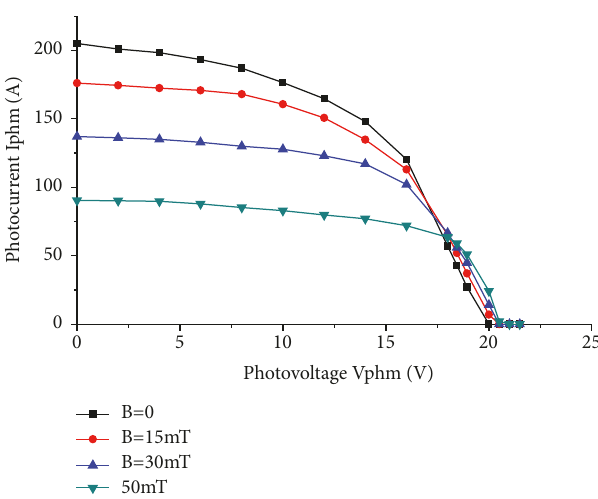
Figure 5: Experimental I-V characteristics at different intensity of the magnetic